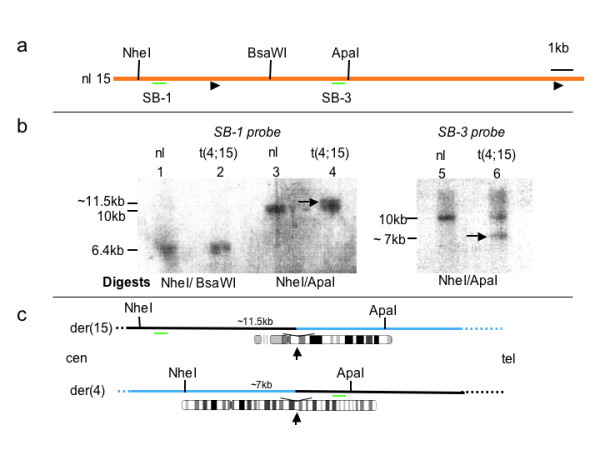
Southern blot analysis identifies breakpoint in SNRPN intron 17 . a . Restriction map of the intron 17 region of the SNRPN gene on the normal chromosome 15. Black arrowheads indicate the boundaries of intron 17. The positions of the two hybridization probes (SB-1 and SB-3) are indicated by green lines. b . Lanes 1 and 2 contain double digests with NheI and BsaWI to release a fragment of 6.4 kb, lanes 3 and 4 contain double digests with NheI and ApaI to release a fragment of 10 kb. The membrane was probed with probe SB-1. The arrow indicates an additional band above the 10 kb fragment ~11.5 kb in length. The two bands are not well resolved on the rendition of this blot. This novel fragment is represented in c, upper panel. Lanes 5 and 6 contain double digests with NheI and ApaI to release a 10 kb fragment. The membrane is probed with SB-3. The arrow indicates an additional band of ~ 7 kb. This novel fragment is represented schematically in c, lower panel. c . Schematic representation of the junction fragments identified on the Southern blot in b. The upper panel represents the der(15) and the lower panel represents the der(4). Chromosome 15 material is indicated as a black line and material from chromosome 4 as a blue line. Location of restriction sites and of hybridization probes (green lines) are indicated.